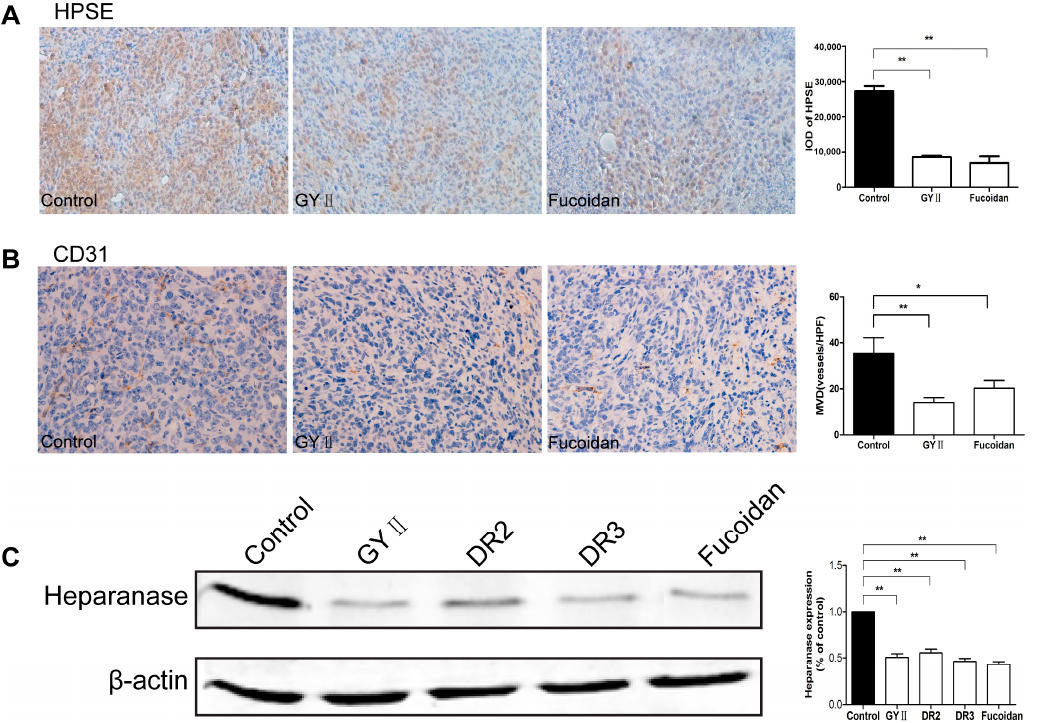
Figure 6. GYII and its decomposed recipes decreased the expression of heparanase and reduced angiogenesis. Formalin-fixed, paraffin-embedded 5 micron sections of the 4T1 breast tumors dissected from animals were immunostained with anti-heparanase ( A ) and anti-CD31 ( B ) antibodies (200× magnification). After exposure to the test compounds for 36 h, the total protein from each cell lysate was analyzed by Western blotting to measure the expression of heparanase ( C ). Data are presented as the mean ± SD and normalized to β -actin (* p < 0.05, ** p < 0.01).